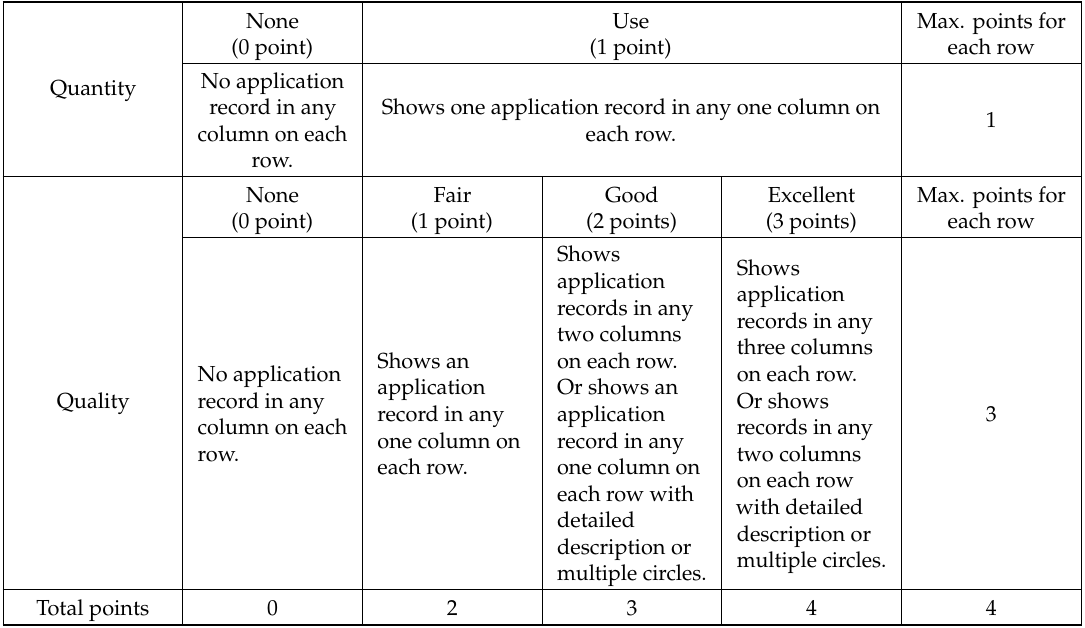
Table A3. Scoring rubric for strategy use on the application